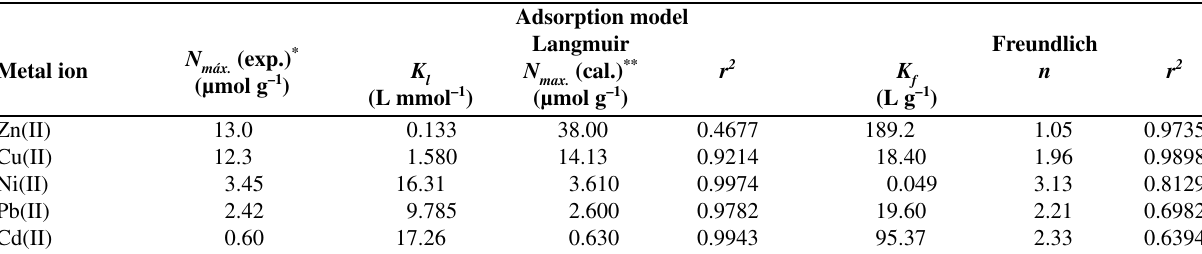
Table 2. Parameters of the linearized Langmuir and Freundlich models for the adsorption of Cu(II), Cd(II), Zn(II), Pb(II), and Ni(II); their maxi- mum adsorption capacities; and the linear correlation coefficient obtained for each